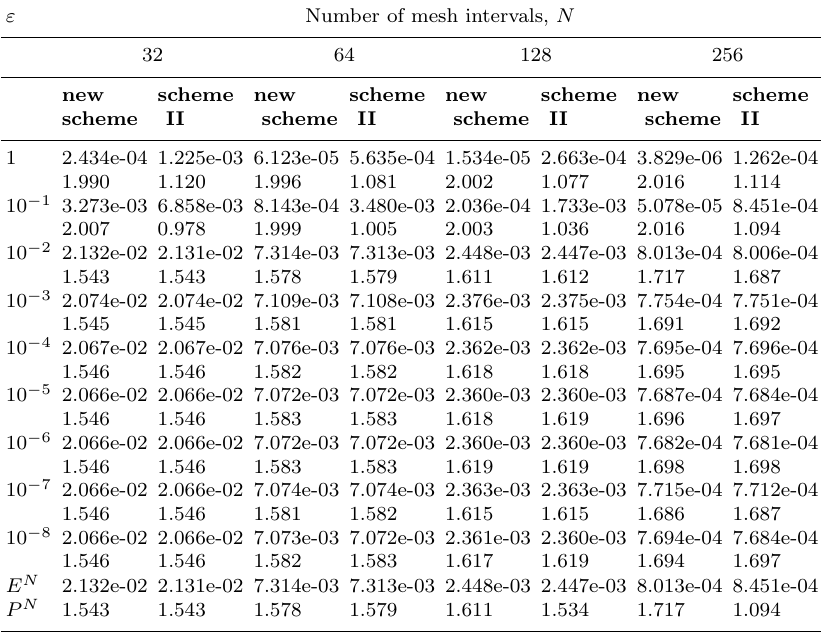
Table 3. Maximum point-wise errors and order of convergence for Example 3.